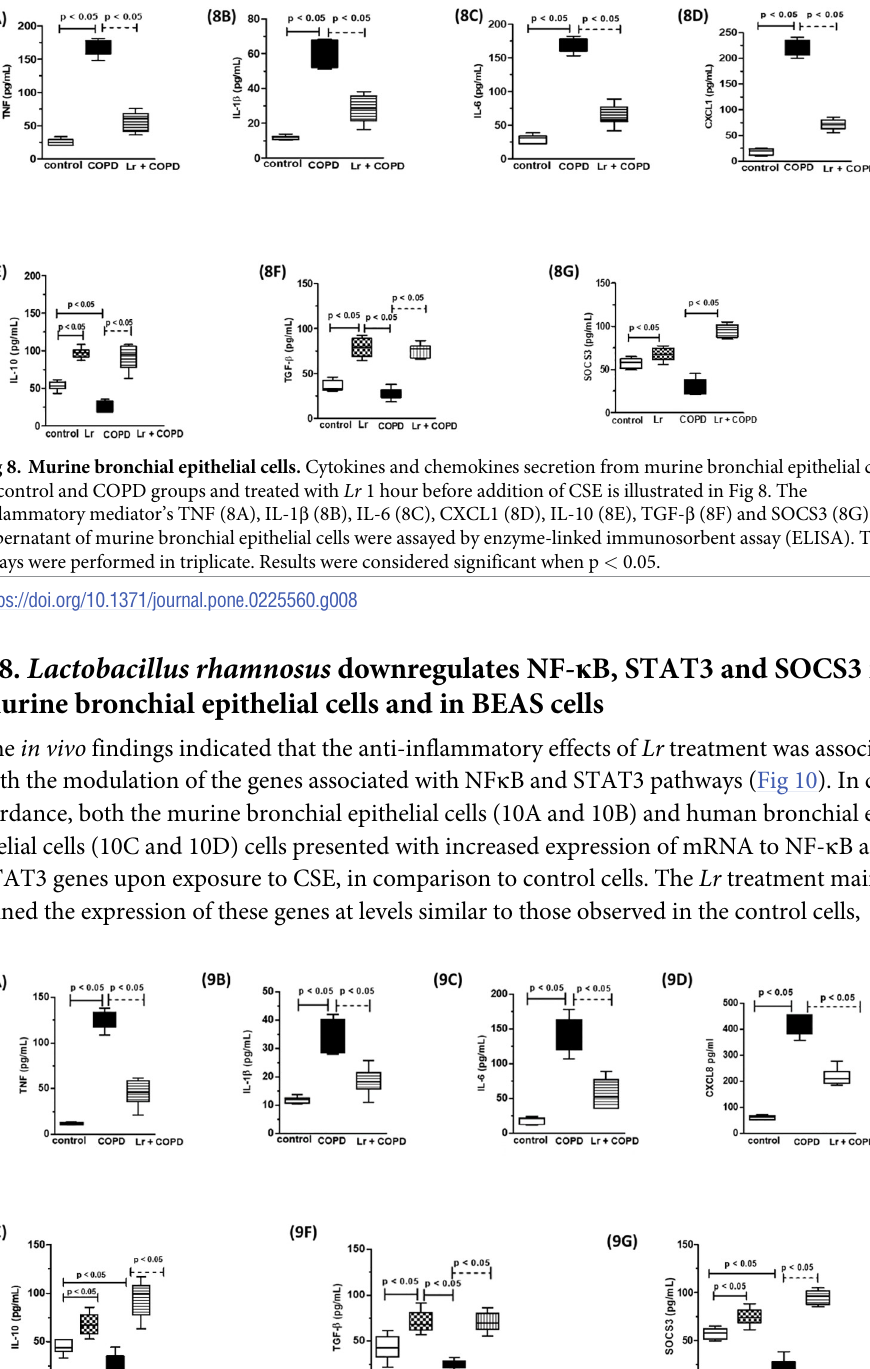
Fig 9. Human bronchial epithelial cells (BEAS). Cytokines and chemokines secretion from BEAS cells stimulated with CSE and treated with Lr are illustrated in Fig 9. The inflammatory mediator’s TNF (9A), IL-1 β (9B), IL-6 (9C), CXCL8 (9D), IL-10 (9E), TGF β (9F) and SOCS3 (9G) in supernatant of human bronchial epithelial cells were assayed by enzyme-linked immunosorbent assay (ELISA). The assays were performed in triplicate. Results were considered significant when p <